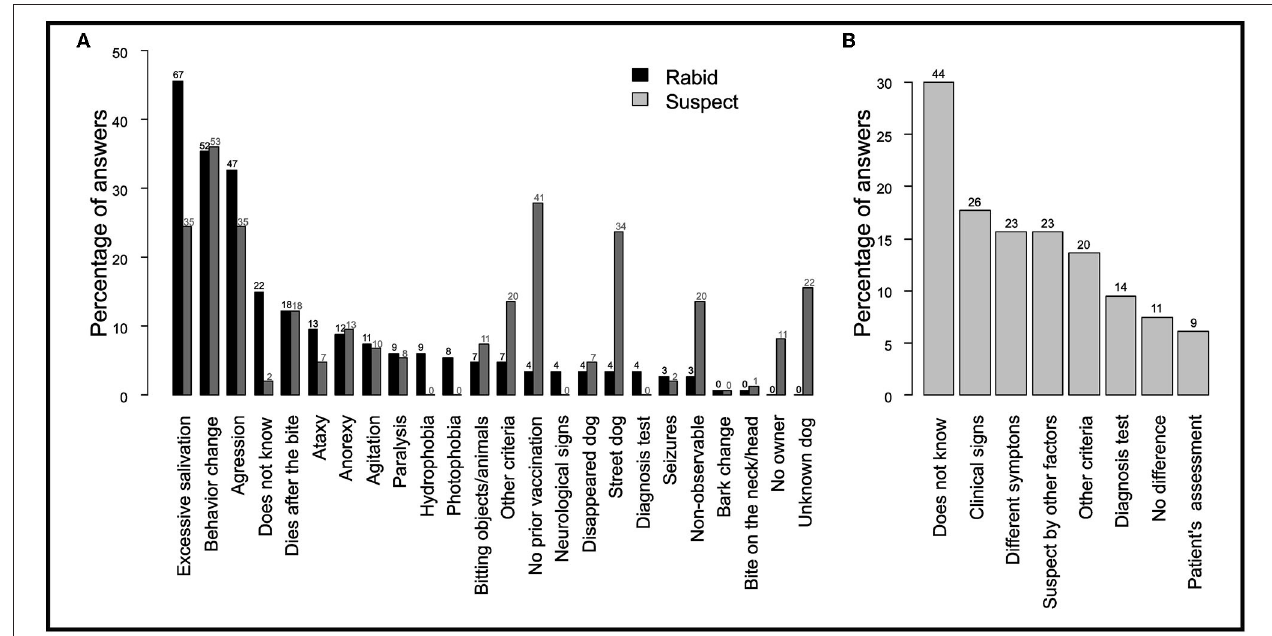
FIGURE 1 | Criteria used by health professionals to classify a dog as “suspect” of rabies or “rabid.” Reported criteria used by health professionals to (A) define a “rabid” and “suspect” dog, and (B) distinguish between a “suspect” and “rabid” dog. The y-axis represents the percentage of professionals that included that criterion (out of 147 respondents). Respondents could mention more than one